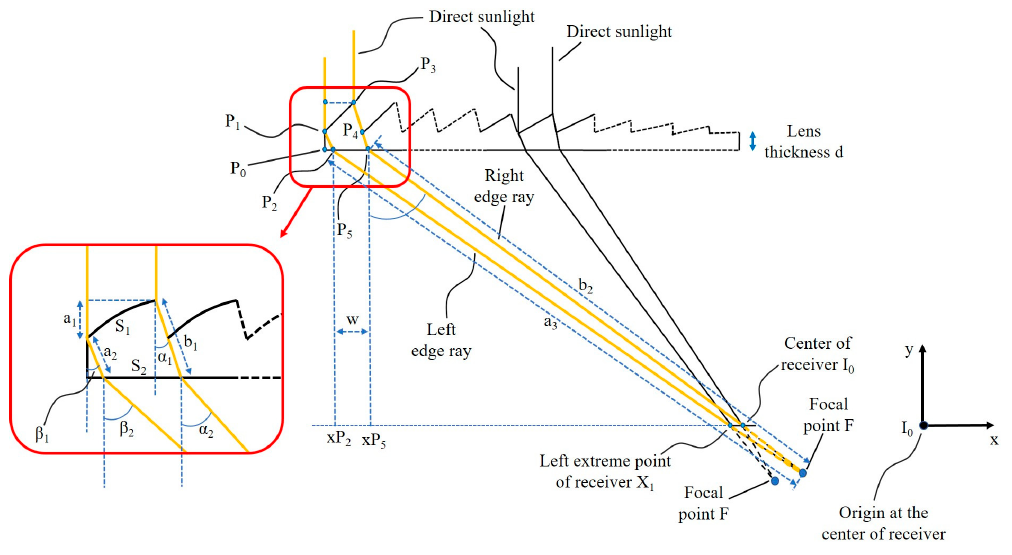
Figure 9. The way to distribute the direct sunlight in each groove of the linear Fresnel lens as an upper groove surface.